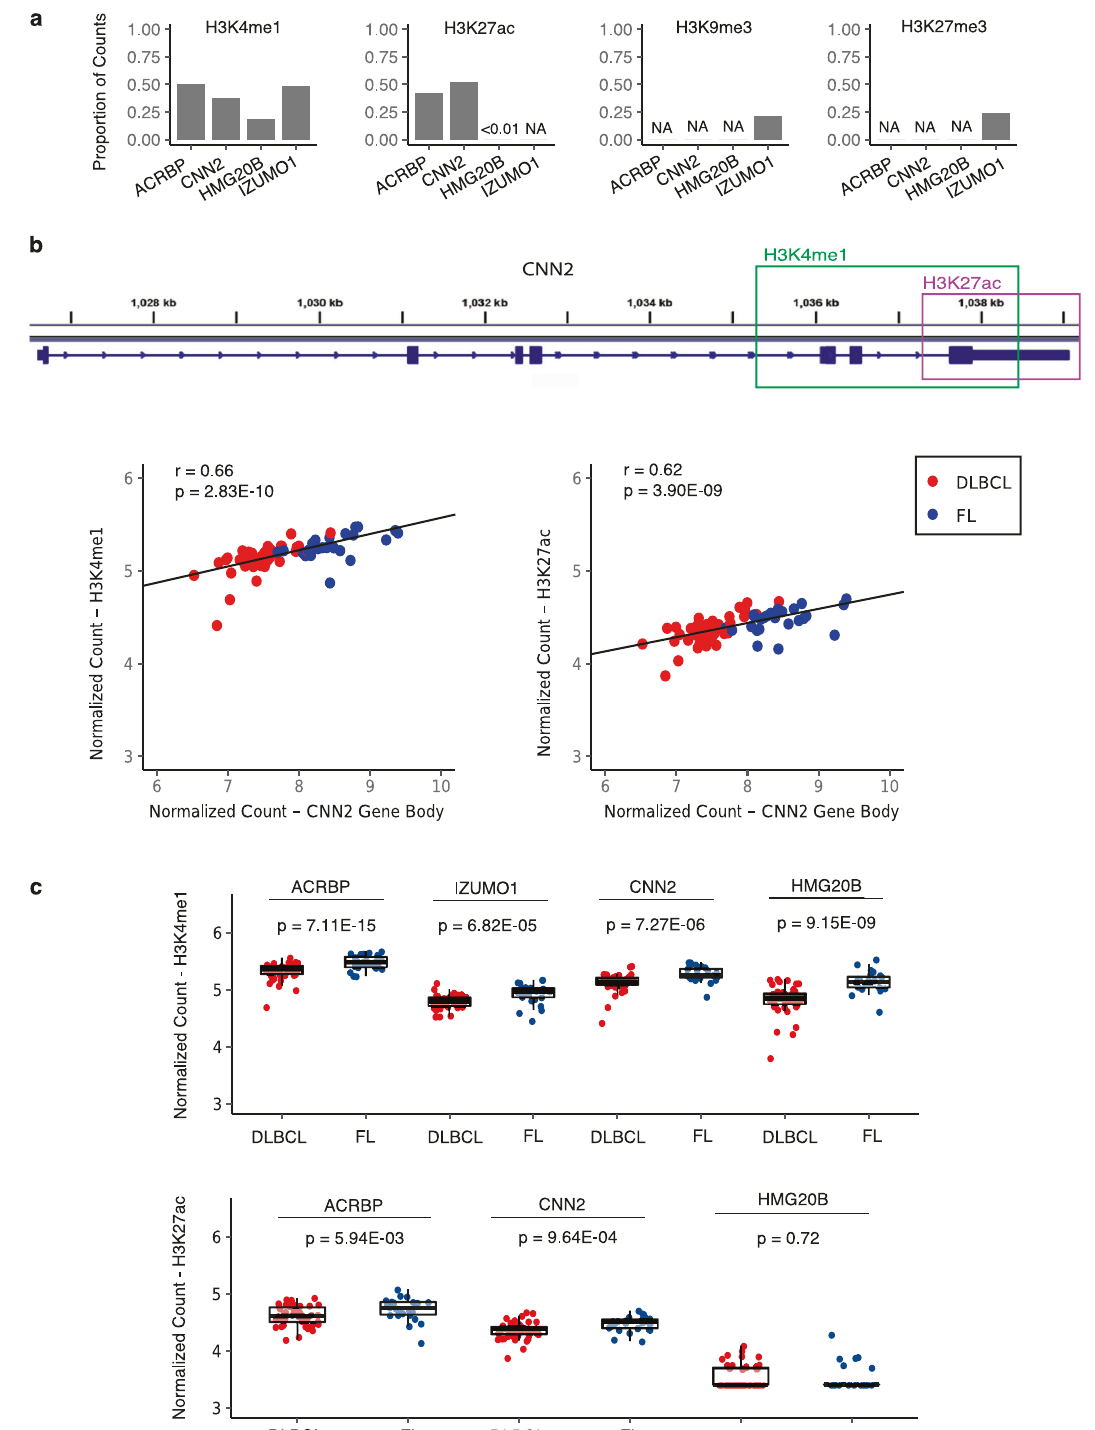
Fig. 3 Gene regulatory relevance of the differentially modi fi ed 5hmC in signature genes. a The proportion of 5hmC read counts in a particular histone modi fi cation mark relative to the read counts in the gene body is shown for each signature gene. b The 5hmC read counts in CNN2 are co-localized with enhancer markers (e.g., H3K4me1 and H3K27ac). c The 5hmC read counts co-localized in respective cis -regulatory elements show differential modi fi cation between DLBCL and FL. The coordinates of histone modi fi cation marks are based on the narrow peaks from the Roadmap Epigenomics Project ’ s B-cell data (accessed on July 25, 2020). Genomic positions are based on the human genome reference (hg19). Statistical signi fi cance of the difference between DLBCL and FL was tested using the Wilcoxon signed-rank tests. DLBCL diffuse large B-cell lymphoma, FL follicular